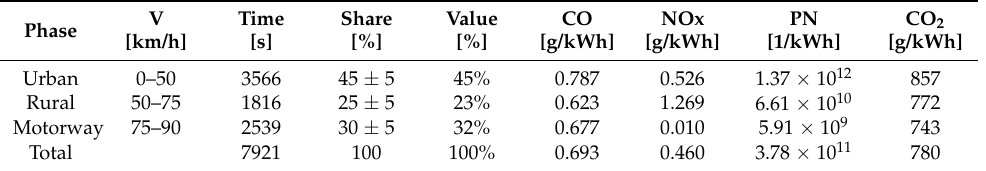
Table 3. Results of tests of unit emission from a heavy-duty vehicle of N2